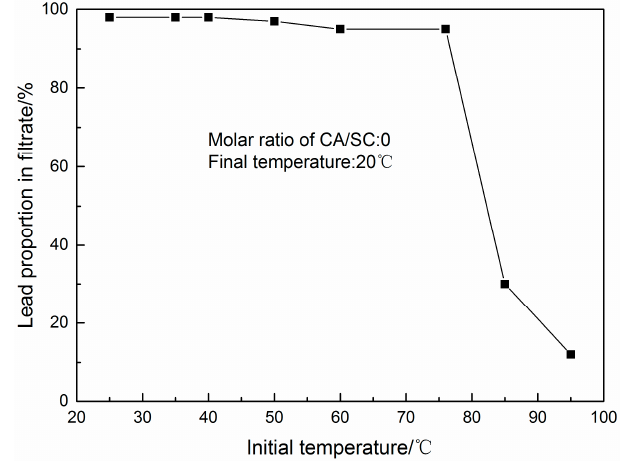
Figure 5. Lead proportion in filtrate with different initial temperatures (molar ratio of CA/SC is 0, final temperature is 20 °C).